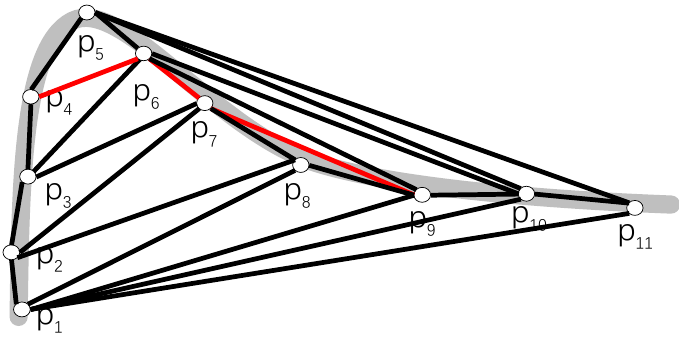
Figure 9. Interpolation results with edges as the weight (Red line segment).